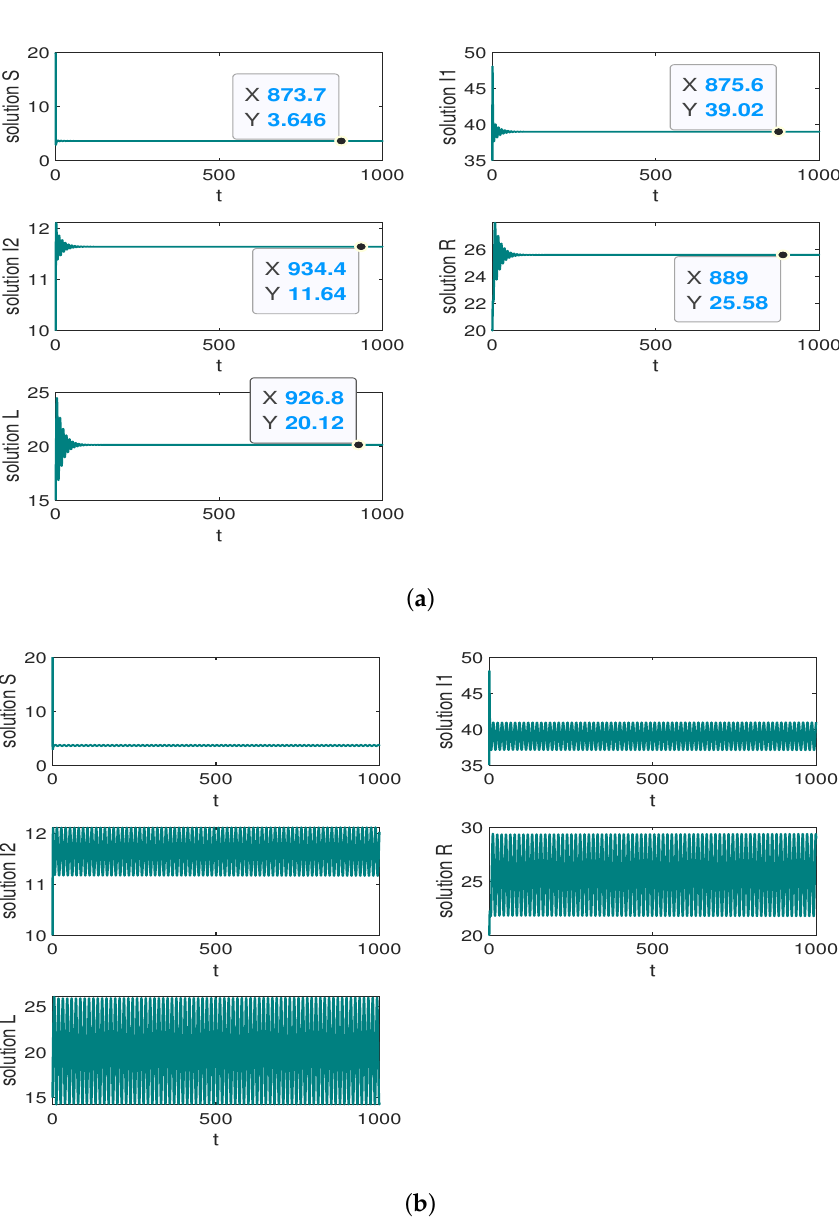
Figure 5. The variation diagram of state nodes. ( a ) The variation in the state nodes when τ = 3.2049 < τ 30 = 4.9049. ( b ) The variation in the state nodes when τ = 4.9050 > τ 30